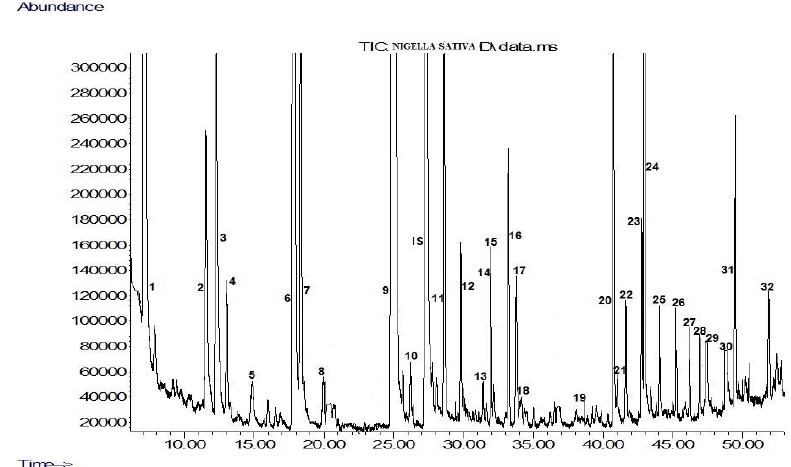
Figure 2. Gas chromatography-mass spectrometry (GC-MS) chromatogram of black cumin seed extract. 1: 2-Methyl-3-butanol, 2: m -xylene, 3: 3-penten-2-ol, 4: limonene, 5: styrene, 6: acetoin, 7: hydroxyacetone, 8: ( Z )-2-methyl-2-buten-1-ol, 9: acetic acid, 10: furfural, IS: internal standard (4- nonanol), 11: propanoic acid, 12: isobutanoic acid, 13: butyrolactone, 14: butanoic acid, 15: propenoic